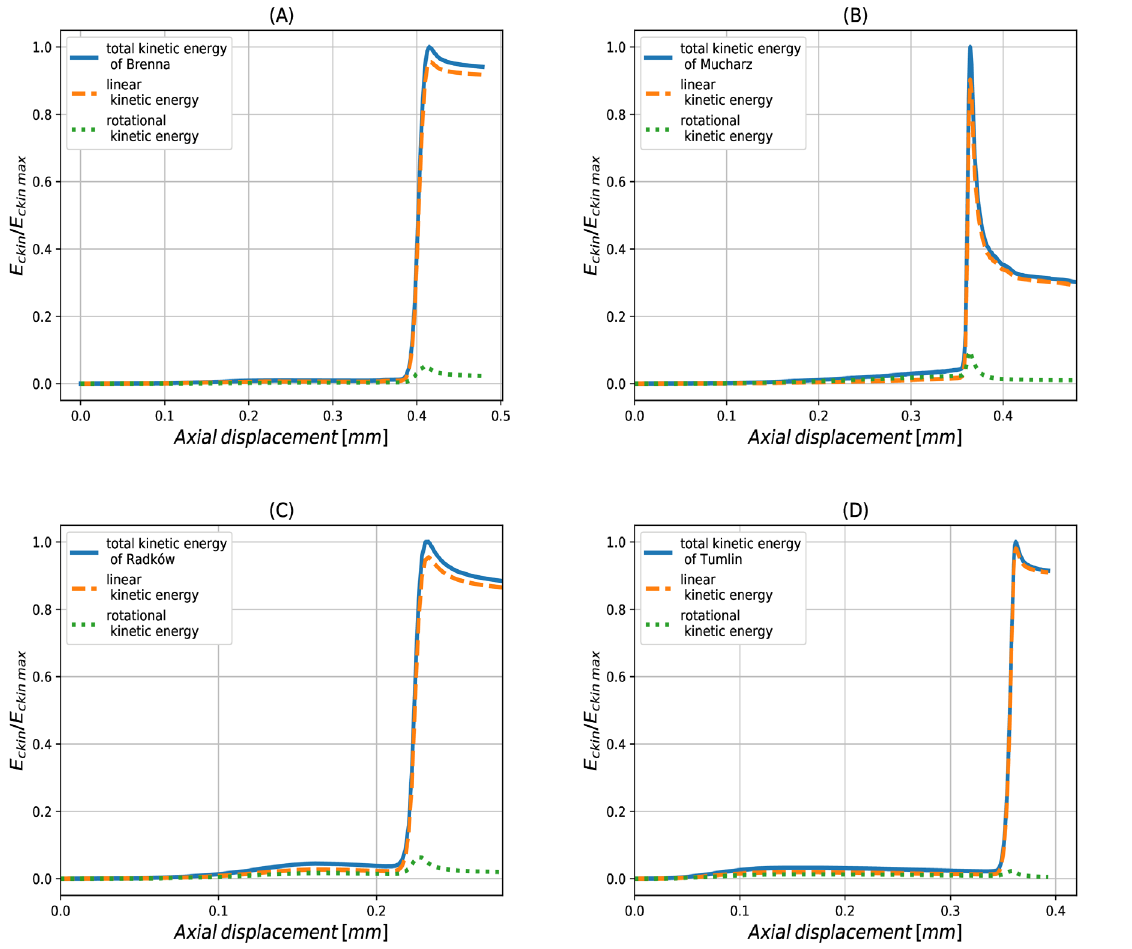
/ E – kinetic energy divided by maximum kinetic ckin ckin max